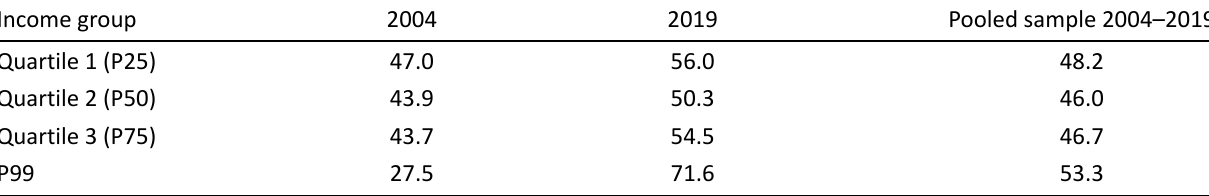
Table 3. Female annual labor income as a proportion of male annual labor income, in %. Income